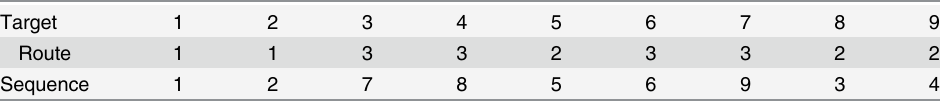
Table 2. Representation scheme 1: Vehicle-oriented